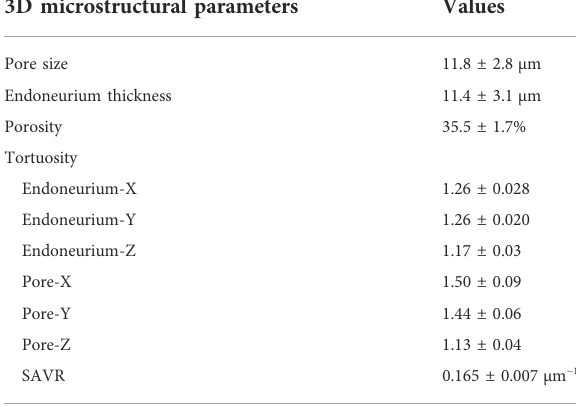
TABLE 2 3D microstructural parameters of endoneurium